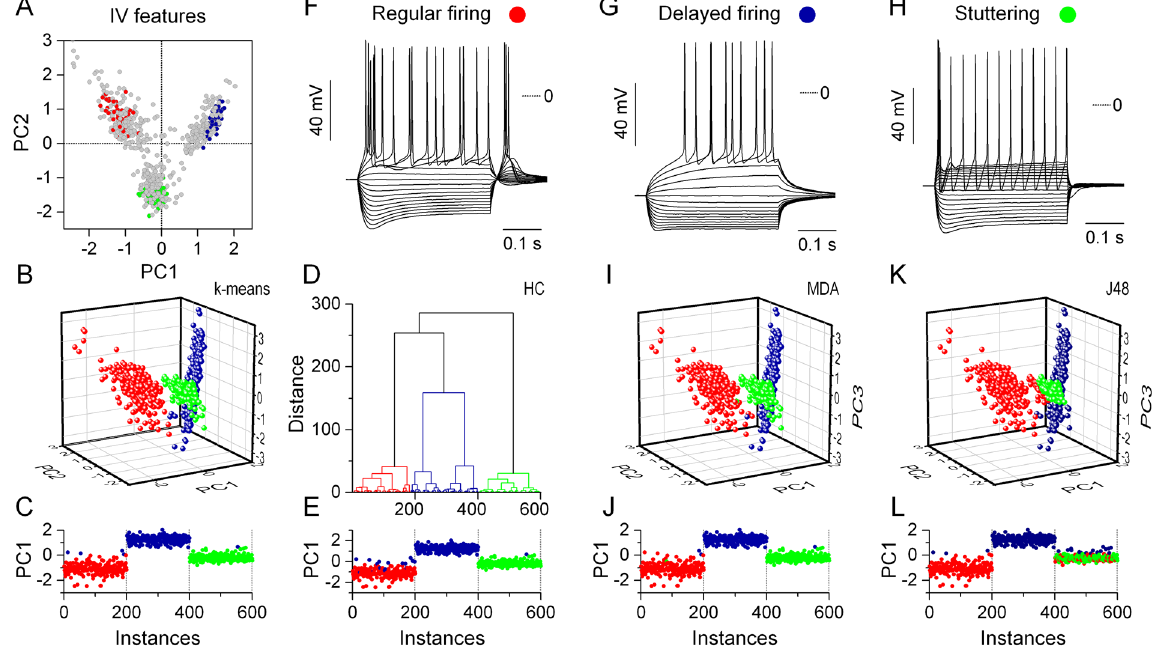
Figure 3. Classification algorithms using physiological parameters identify three groups of neurons corresponding to the three biophysical phenotypes. The first two principal components calculated from the 20-dimensional IV feature vectors are scatter plotted in ( A ). For unsupervised clustering we use 3-dimensional PC vectors and color them according to the membership values determined by the k-means ( B ) and hierarchical clustering ( D ) methods. PC1 vs. instance number plots demonstrate how accurately these methods identify the different biophysical phenotypes. ( C,E ) Here, the first 200 instances are all regular firing type cells followed by the delayed and stuttering types. As training set for the multidiscriminant analysis (MDA) and J48 methods we manually selected a total of 120 (3 × 40) model instances and labeled them as regular firing, delayed firing and stuttering neurons (colored points in A ). Representative examples of the voltage responses of such model neurons are shown in ( F–H ). The output of the MDA and J48 methods based on this training set are shown in ( I – L ). Both supervised classification methods identify the original 3 groups of biophysical phenotypes almost